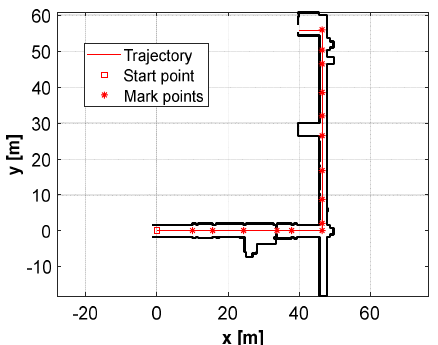
Figure 10. An illustration on the corridor plan, the ideal trajectory, and markers.